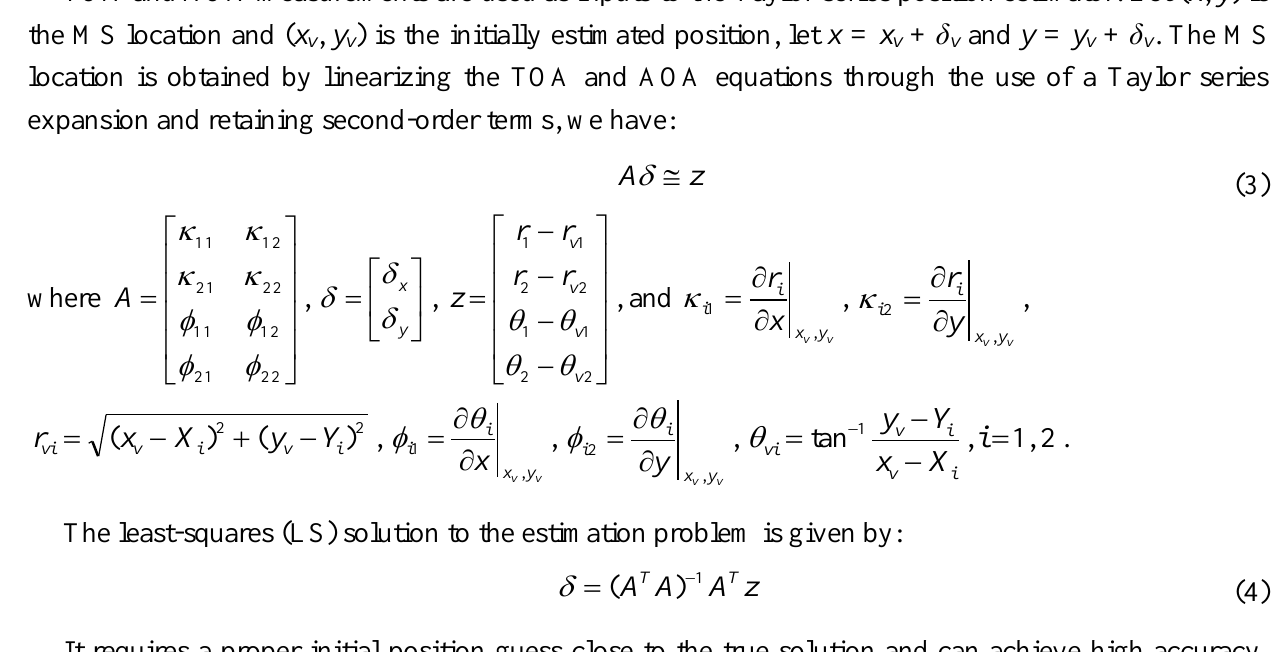
Fig. 1. Location with two BSs (a) Original coordinates (b) New